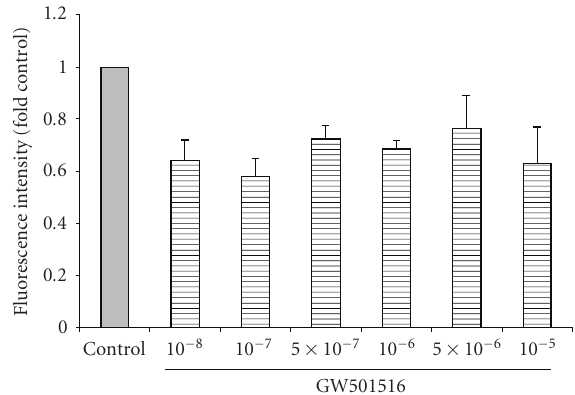
Figure 7: GW501516 does not significantly alter IMCD-K2 cell via- bility. Serum-starved cells were stimulated for 24 hours with serum- free media (control) or increasing concentrations of GW501516 (10 − 8 to 10 − 5 M). The cells were then incubated for one hour with the DNA dye-binding solution from the CyQUANT NF assay kit (Invitrogen). Fluorescence intensity, representing number of cells, was then measured as per the manufacturer’s instructions. Values (fold control) are means ± S.E.M.; n = 3.